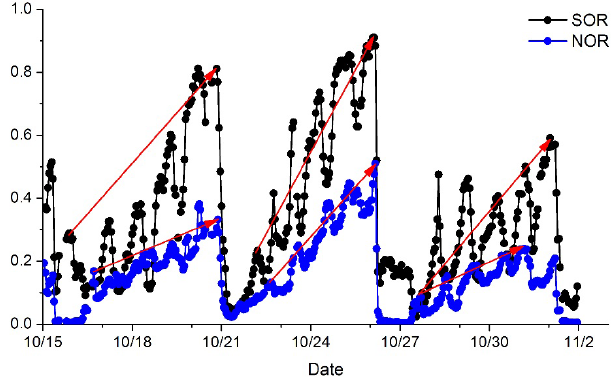
Figure 7. Time series of SOR (sulfate oxidation rate) and NOR (ni- trate oxidation rate) from 15 October to 2 November